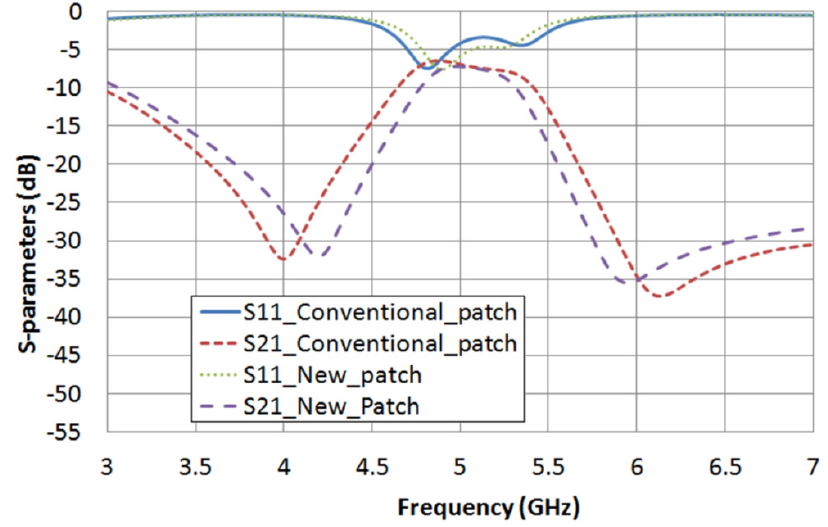
Figure 10. S-parameters obtained in simulation for both structures considering ε and tan δ ⊥ = 0.05.